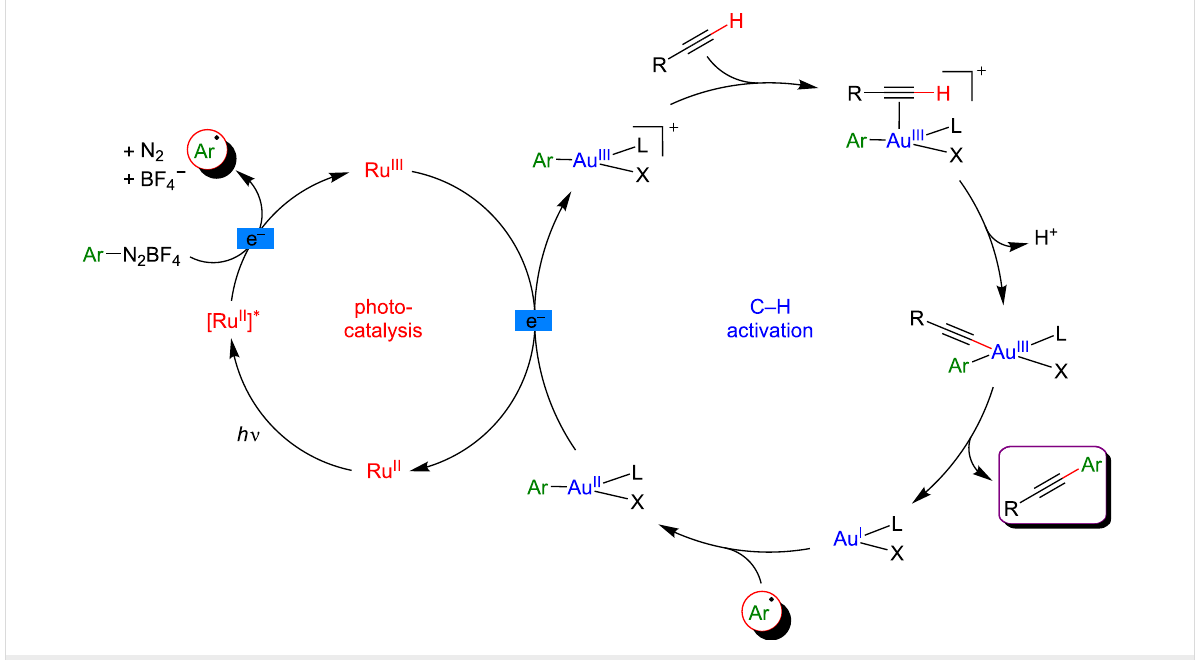
Figure 53: Proposed mechanism for the arylation of terminal alkynes via dual catalysis.